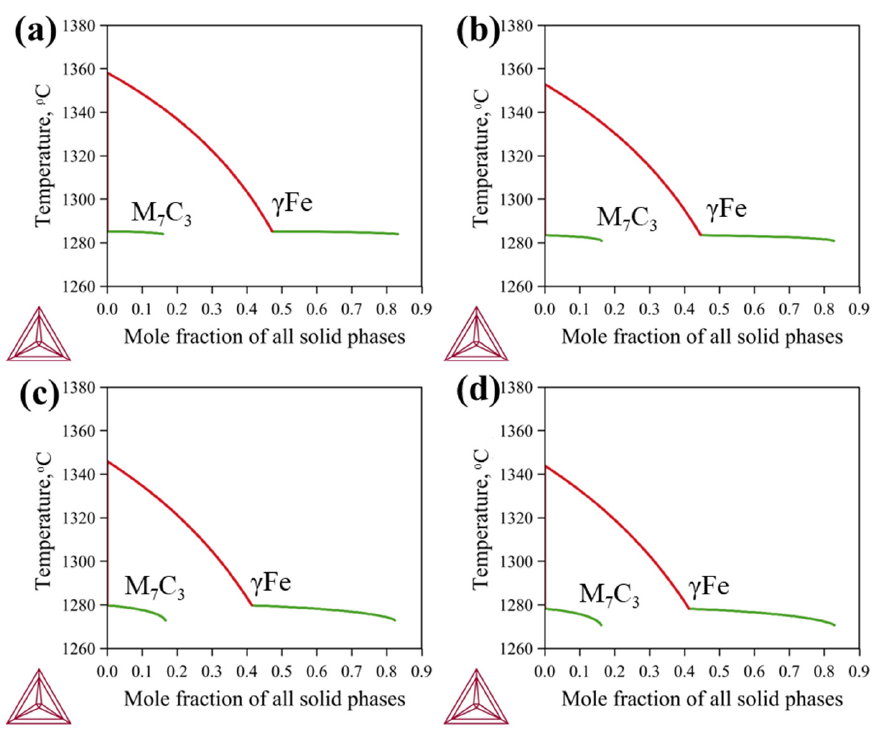
Figure 3. Calculated solidification paths of the CICs according to the modified Scheil–Gulliver simulation: ( a ) CIC-1; ( b ) CIC-2; ( c ) CIC-3; ( d ) CIC-4.